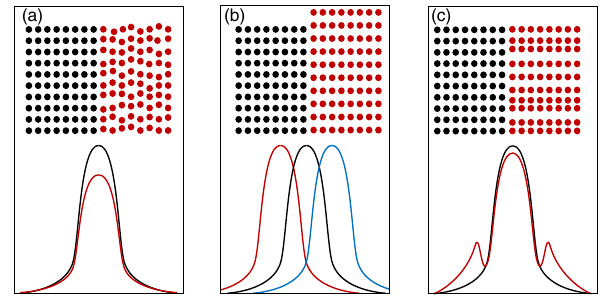
FIG. 2. Three schematic presentations of lattice distortion. In each case, the strained crystal (red dot) is compared with undistorted lattice (black dot). The lower panel shows the impact of the distortion on the reflectivity curve of Bragg reflection. (a) Random disorder decreases the Bragg peaks. (b) Homogeneous deformations lead to spectral shifts depending on the relative change of the lattice parameter. (c) Longitudinal nonlinear strains create sidebands and decrease the Bragg